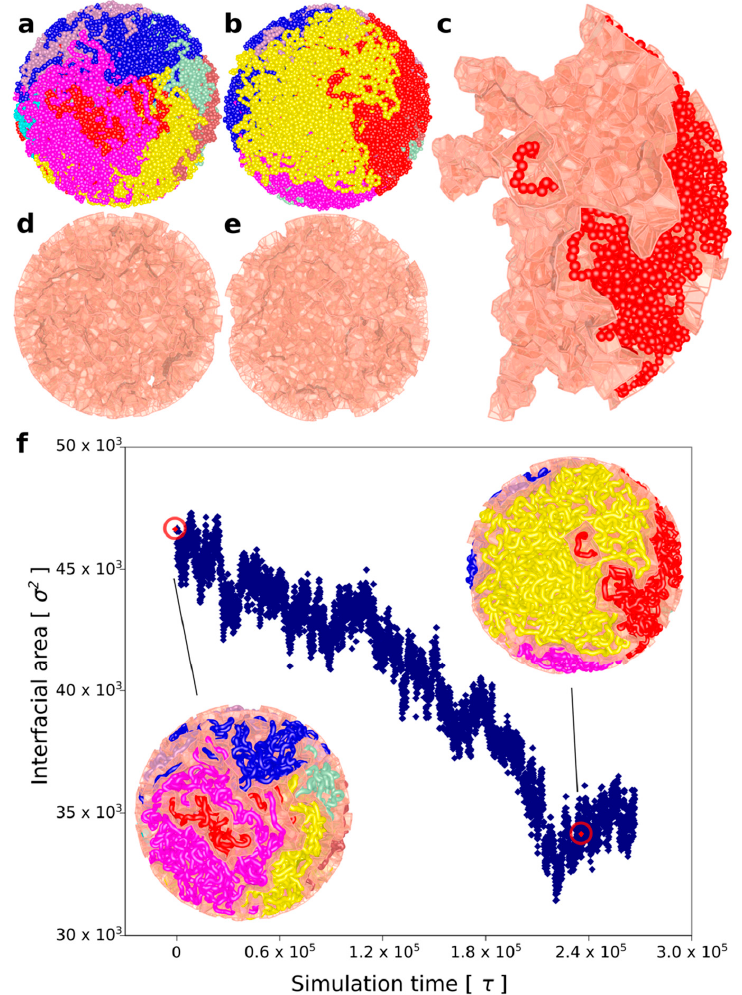
Figure 4. Chromatin loop extrusion demixes topologically equilibrated chromatin loops. ( a ) A